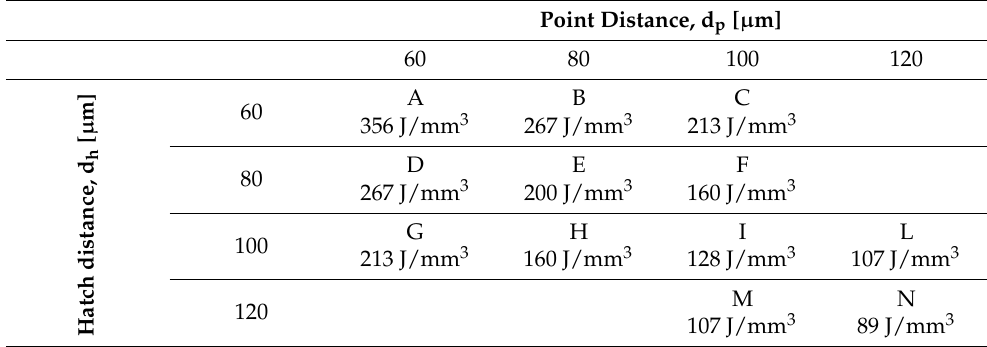
Table 1. Sample names and VED calculated accordingly to Equation (1).